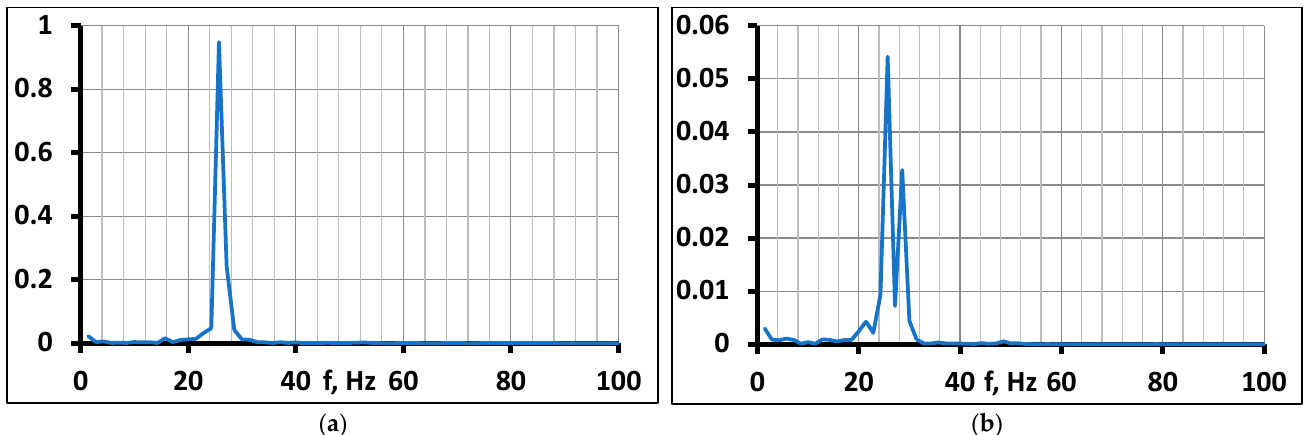
Figure 9. ( a ) The spectrum of the pulsation component of the lifting force (model No. 1); ( b ) The spectrum of the pulsation component of the lifting force (model No. 2).